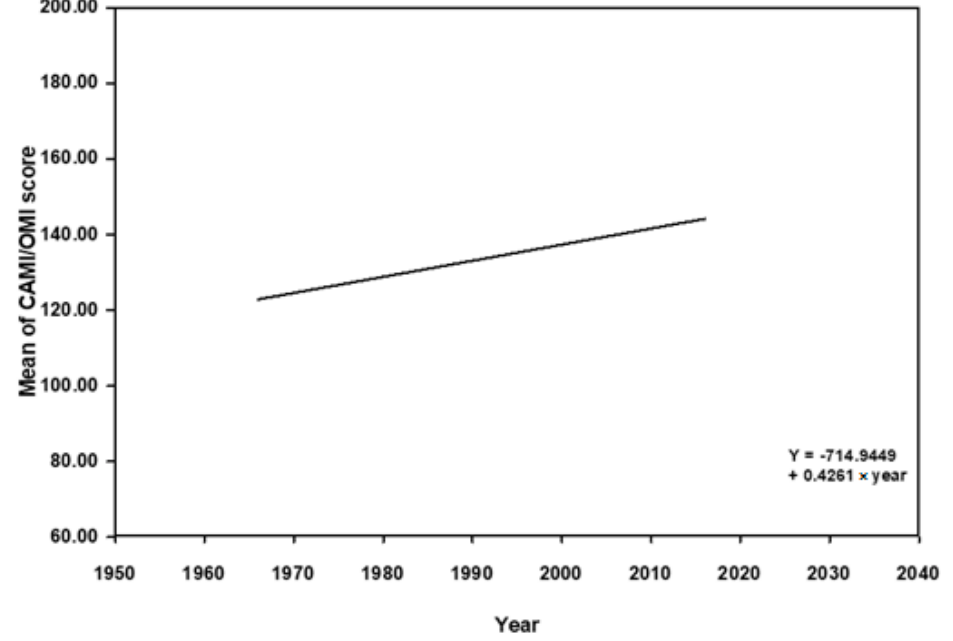
Figure 3. Meta regression of mean of CAMI/OMI score and year of data collection from 1966 to 2016. CAMI: Community Attitudes towards Mental Illness scale; OMI: Opinions about Mental Illness scale.